Question: What does this figure show? Answer in one sentence.
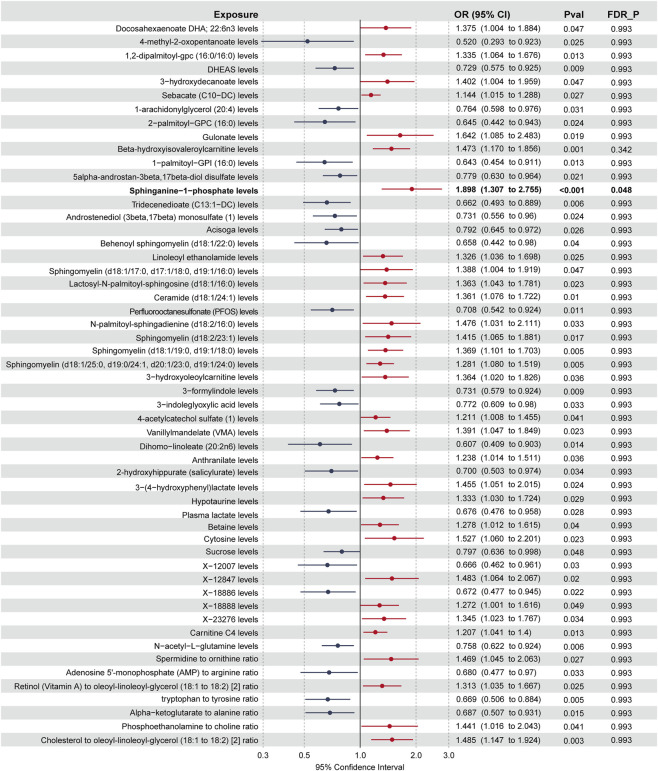
Answer: Forward MR associations between serum metabolites and POI risk using the IVW method. The forest plot shows exposures reaching nominal significance at P IVW <0.05. Sphinganine-1-phosphate remained significant after FDR and Bonferroni correction and was interpreted as a corrected-significant risk-associated metabolite candidate. The remaining exposures were considered nominal MR signals.